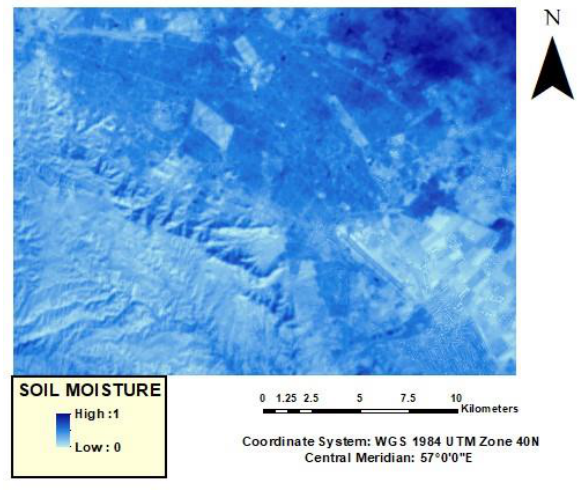
Figure 6. Soil moisture content map calculated by optical and trapezoidal model. The brown colour is showing the highest soil moisture and the blue colour shows lowest soil moisture.